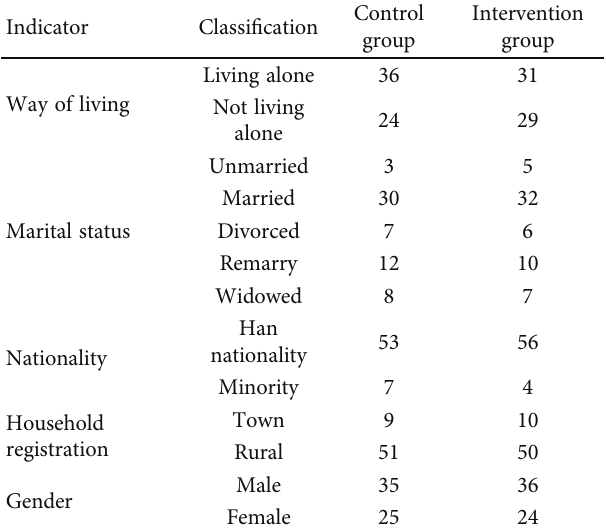
Table 4: Comparative analysis of the general data of the elderly in the two groups of